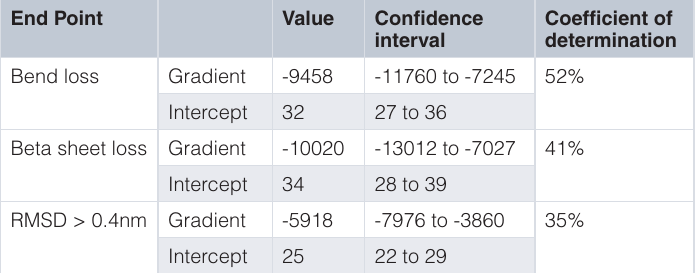
Table 4. Lines of best fit for the Arrhenius equation using all of the